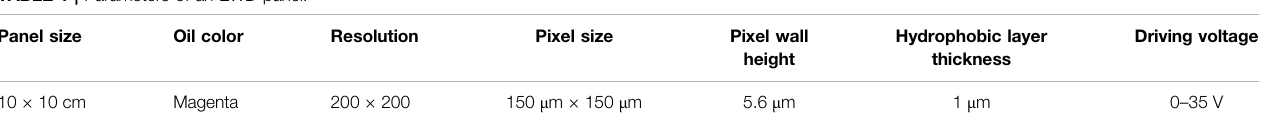
TABLE 1 | Parameters of an EWD panel.